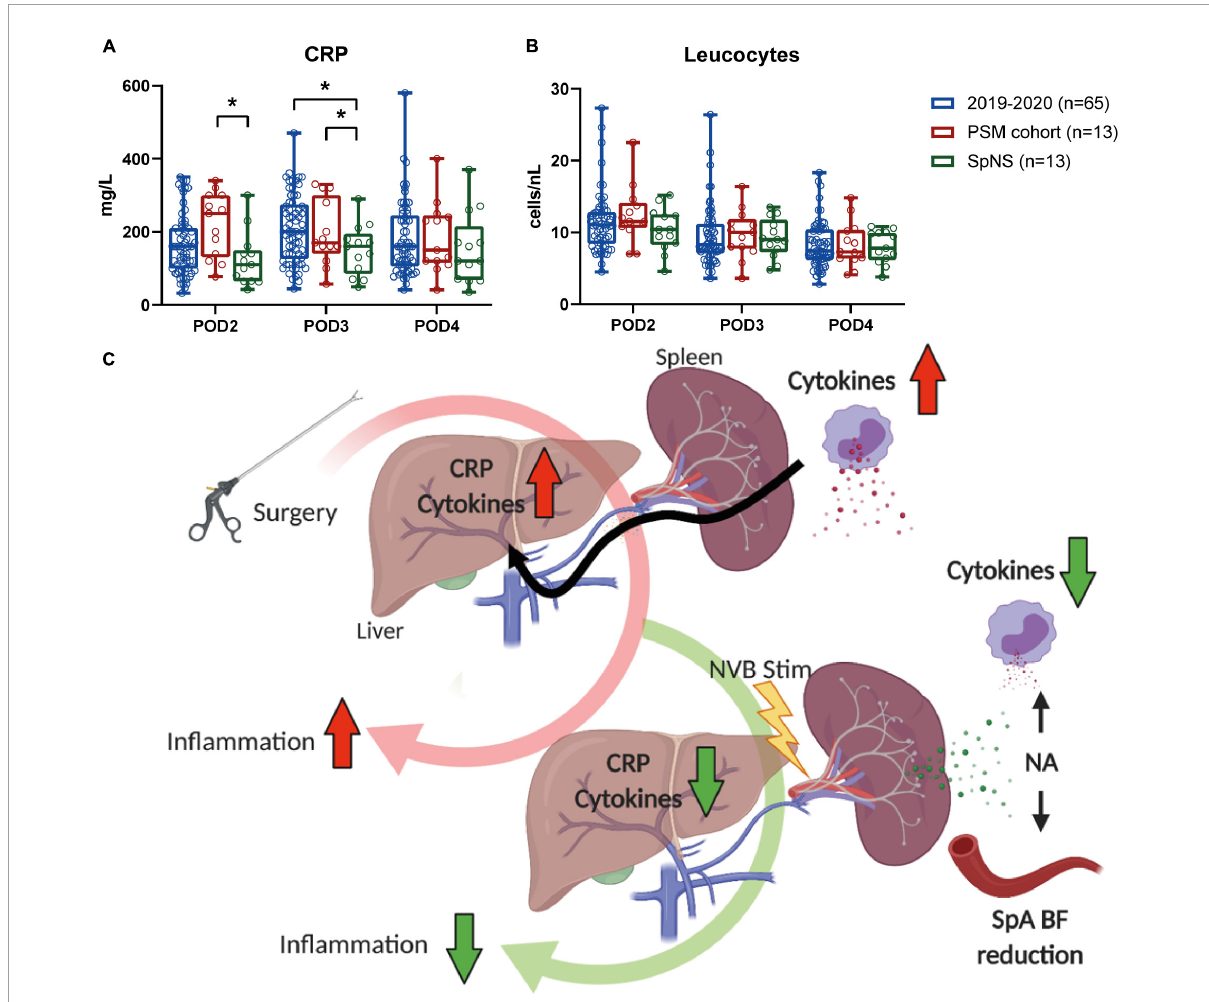
FIGURE3 Postoperative inflammation was lower in patients that underwent SpNS compared to matched controls. (A) Plasma CRP levels and (B) blood leukocytes on POD2–4 in all patients that underwent MIE in 2019, patients that underwent SpNS and patients that were matched to SpNS patients based on the occurrence of major complications, pneumonia, and anastomotic leakage. Bars indicate mean and standard deviation. (C) Schematic representation of the putative mechanism of action. Surgical procedures trigger immunological responses. The accumulation of cytokines and the consequent production of CRP by the liver are biomarkers of postoperative inflammation and correlate with postoperative recovery. When stimulation of the splenic nerve is applied via a stimulation lead placed around the SpA NVB, norepinephrine (NA) is released within the spleen. The neurotransmitter causes contraction of the vascular bed with consequent transient decrease in splenic arterial blood flow that can be used as a biomarker of nerve engagement. At the same time NA binds to spleen resident immune cells and suppresses their ability to produce cytokines. * p <